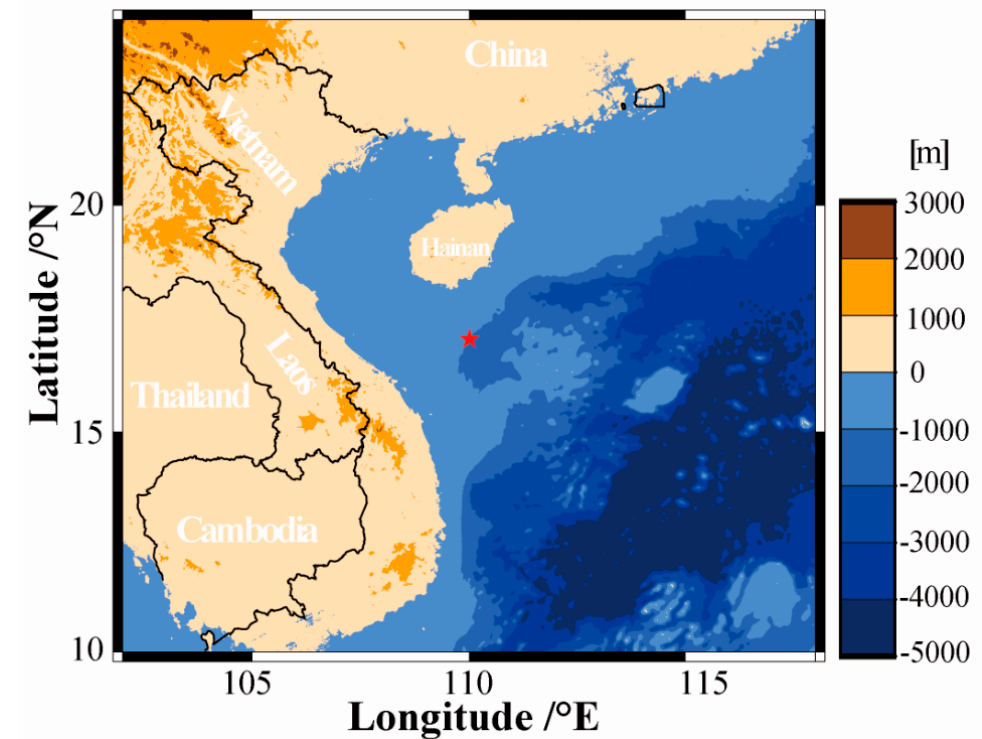
Figure 1. Deployment locations of ‘Phoenix’ lander in the SCS. The red star denotes the site where in situ DNA/RNA co-collection was conducted by MISNAC apparatus in 12 time periods of two days in November 2019 at 1022 m depth (Table S1 for more details).